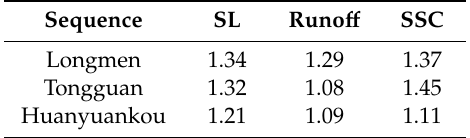
Table 7. Fractal dimension of hydrological series SL, runo ff , SSC.